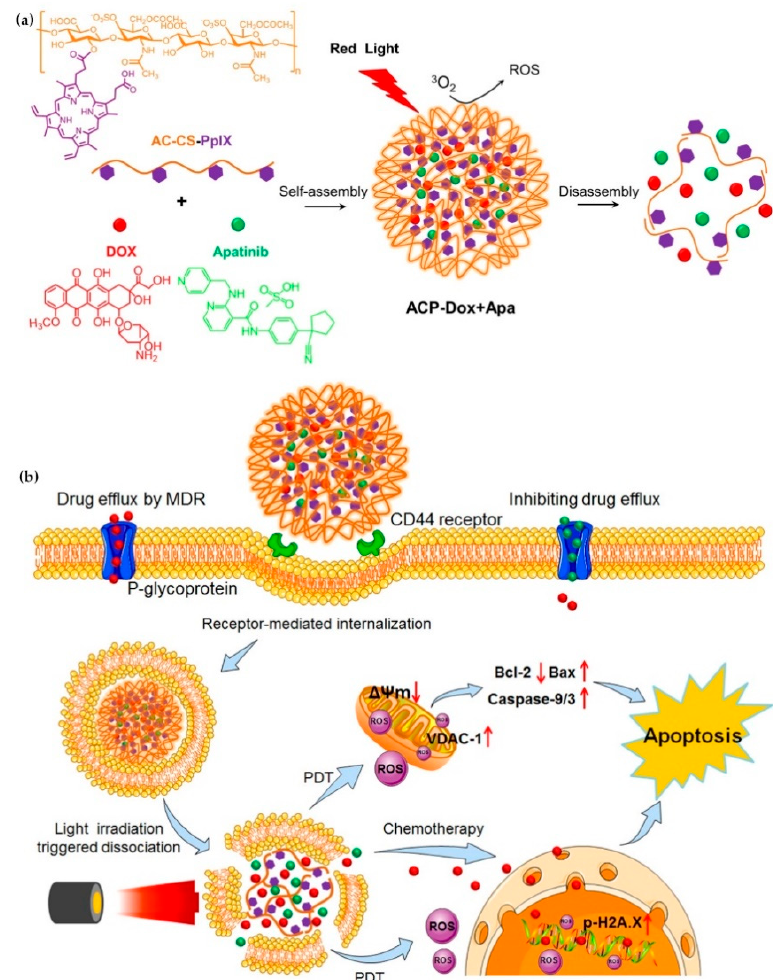
Figure 5. Schematic diagram of a light/ROS-responsive drug delivery platform. ( a ) Formation and cleavage of acetylated-chondroitin sulfate-protoporphyrin (ACP)-Dox + Apa micelles. ( b ) The mechanism of smart ACP-Dox + Apa micelles against multidrug resistance (MDR), for promoting the synergistic antitumor efficacy. Reproduced with permission from the publisher of corresponding reference [106].